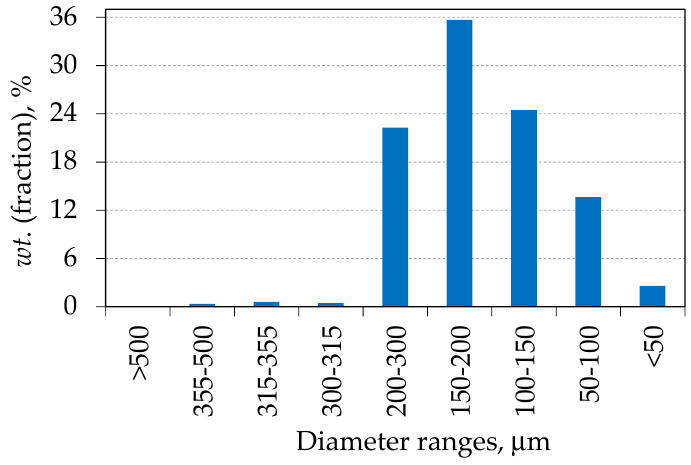
Figure 1. Particle size distribution of the spray-dried alumina granules.